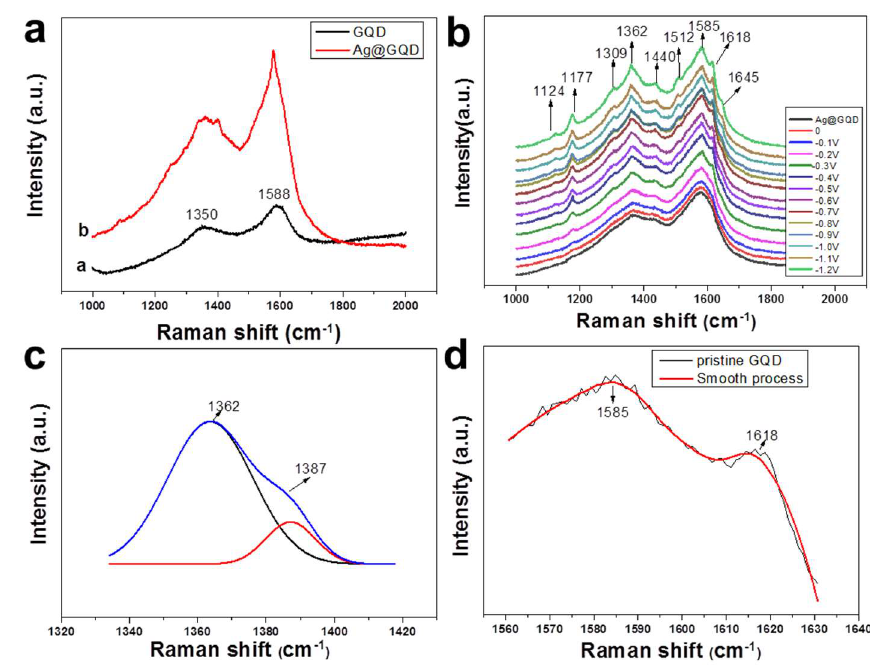
Figure 3. ( a ) Curve a: Raman spectrum of GQDs on silicon, and curve b: Surface-enhanced Raman spectroscopy (SERS) spectrum of GQDs on silver nanoparticles (Ag@GQDs); ( b ) SERS spectra of Ag@GQDs coated on a Ag electrode with changing potentials from 0.0 V to − 1.2 V; ( c ) The D band in SERS at − 1.2 V (blue) and two fittings (black and red); and ( d ) the G band in SERS at − 1.2 V. The excitation wavelength was 532 nm.